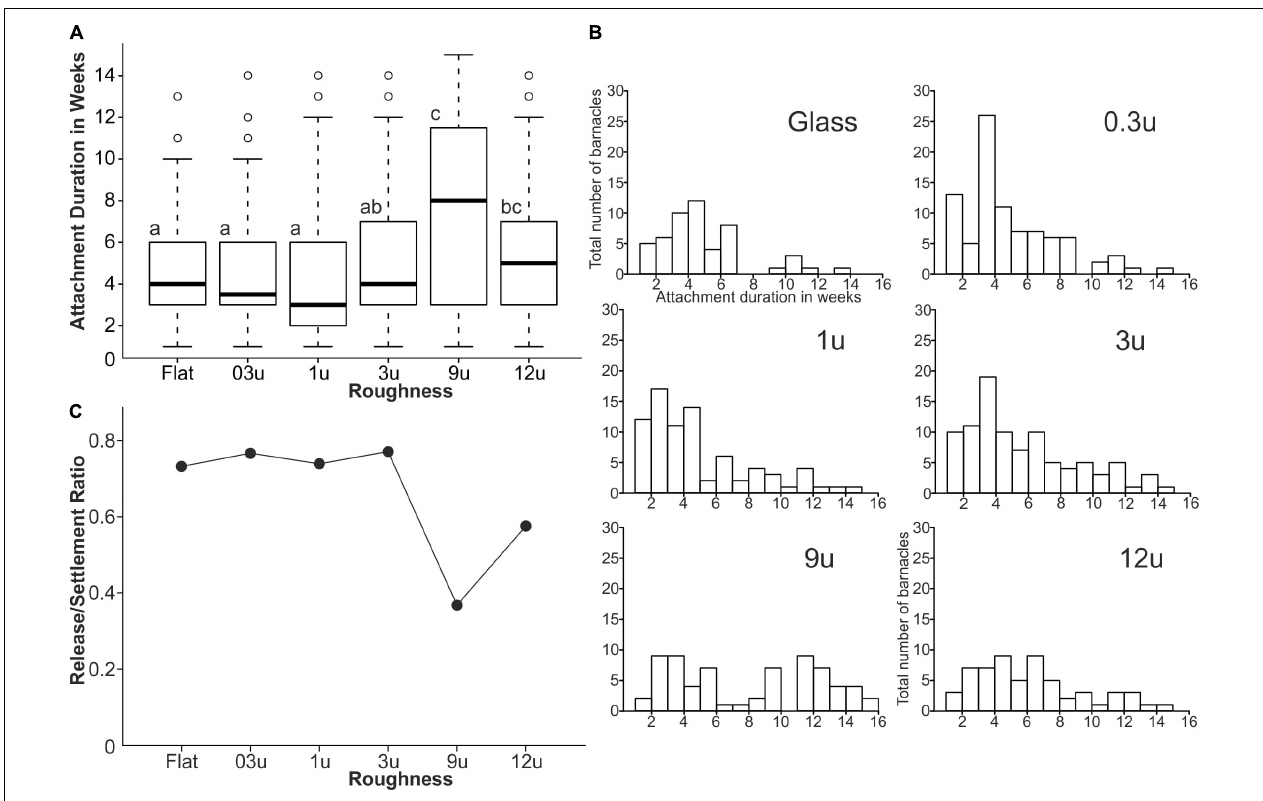
FIGURE 6 | The fouling release ability of PVS type of samples during the field experiment 1. (A) Boxplots showing the average attachment duration for each roughness type (groups with same letters are statistically equal). (B) The frequency histograms of attachment durations for all barnacles on each roughness. (C) Release-to-settlement ratios for all samples with different roughness made of